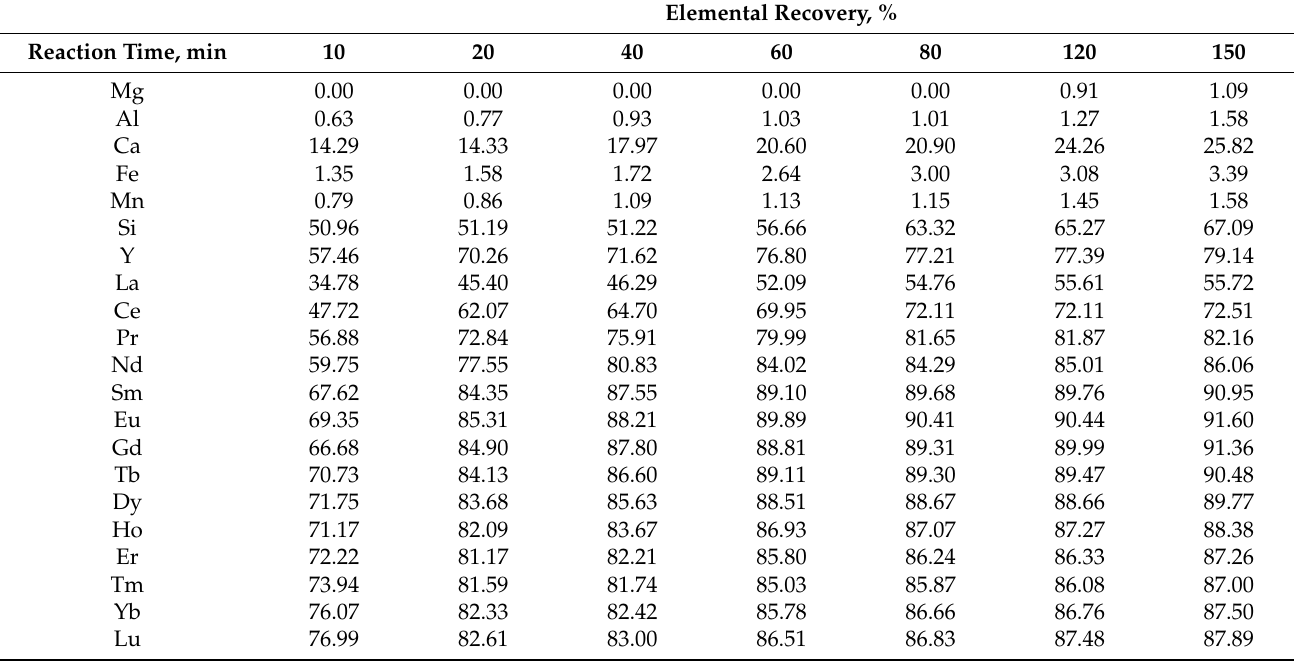
Table 5. Elemental recovery of rare earth elements and contaminants (Al, Ca, Fe, Mn, Si) at a fixed pH of 1.5 and dosage of 15 g/L. Elemental Recovery, %